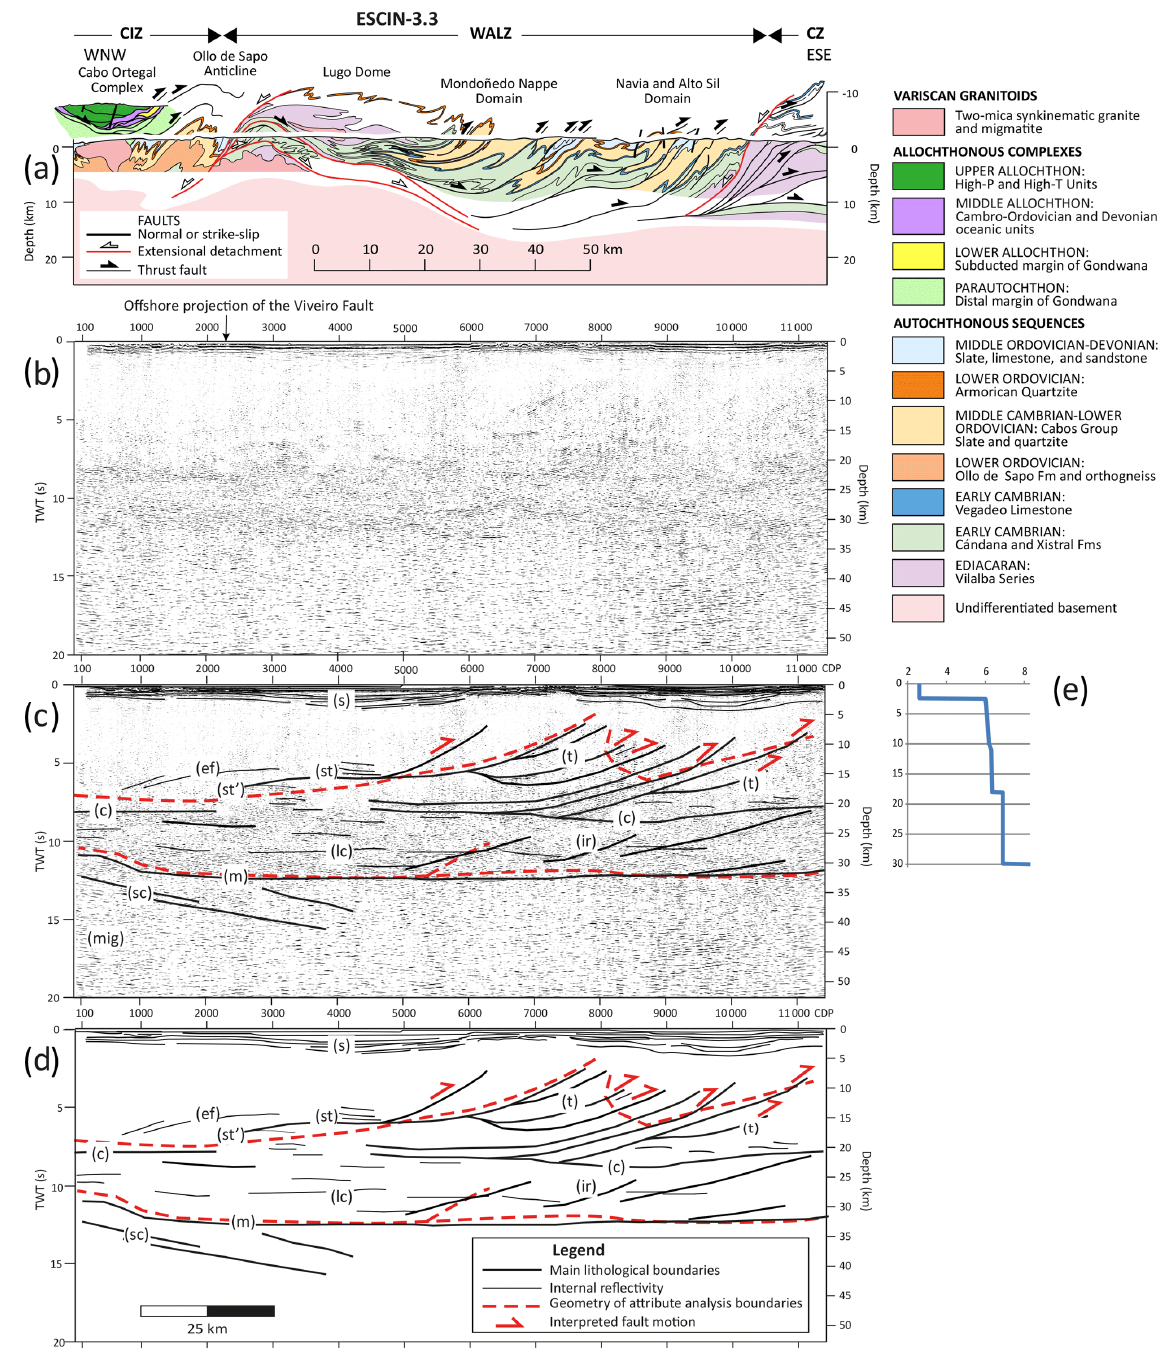
Figure 5. Cross section (a) and depth-converted time-migrated section ( v = 5200m/s) of the NI seismic profile ESCIN-3.3 (Fig. 1), with- out (b) and with (c) interpretation. A sketch of the most important features is presented in panel (d) . A 1D velocity profile as modeled from wide-angle data (Ayarza et al., 1998) is presented in panel (e) . The abbreviations used in the figure are as follows: CDP is the common depth point, TWT is the two-way travel time, CZ is the Cantabrian Zone, WALZ is the West Asturian-Leonese Zone, and CIZ is the Central Iberian Zone. The offshore projection of the Viveiro Fault is indicated. Red dashed lines represent the boundaries provided by chaos and variance attribute analyses. The nomenclature for reflections is as follows: (s) is sediments, (t) is thrusts, (st) denotes sole thrust, (ef) denotes extensional features, (c) is the top of the lower crust, (lc) is the lower crust, (ir) is the lower crust internal reflectivity, (m) is the Moho, (sc) denotes subcrustal reflections, and (mig) denotes curved features resulting from the migration of discontinuous reflections. Depth conversion is based on migration